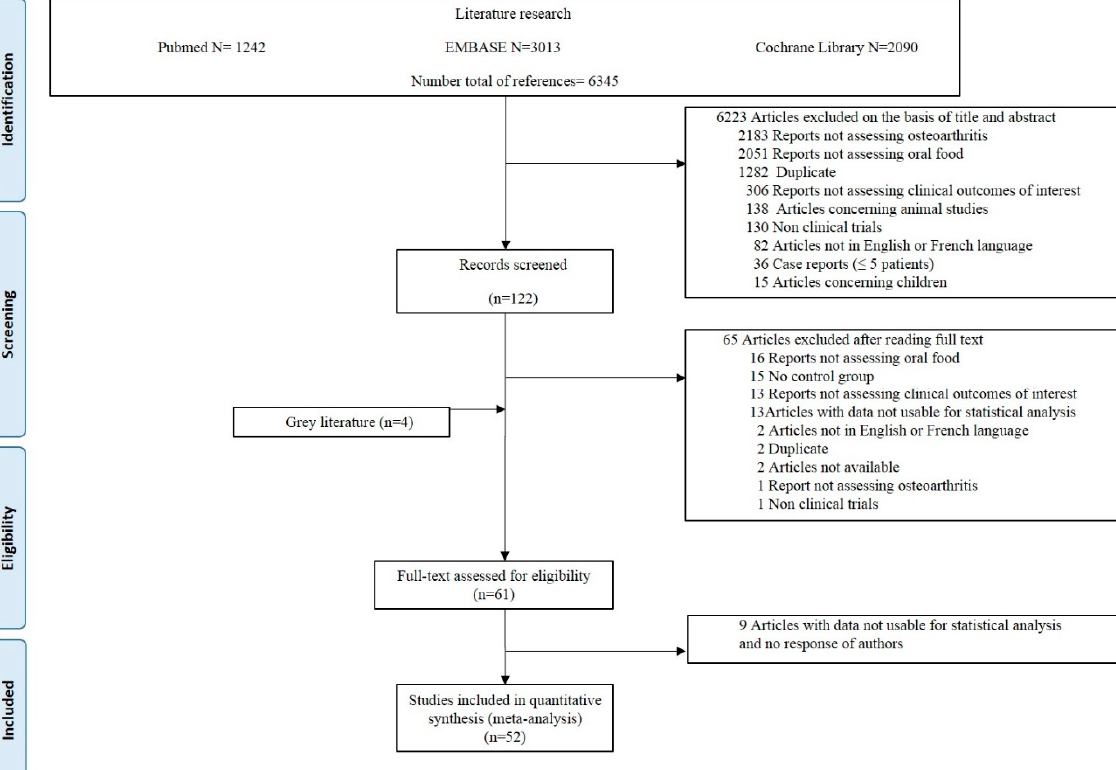
Table 1. Characteristics of the publications included in the meta-analysis.